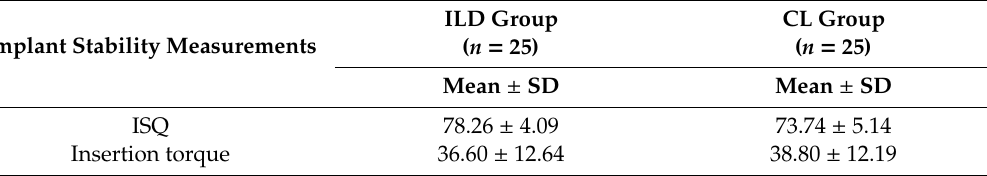
Table 4. Mean and SD for ISQ and insertion torque at the time of